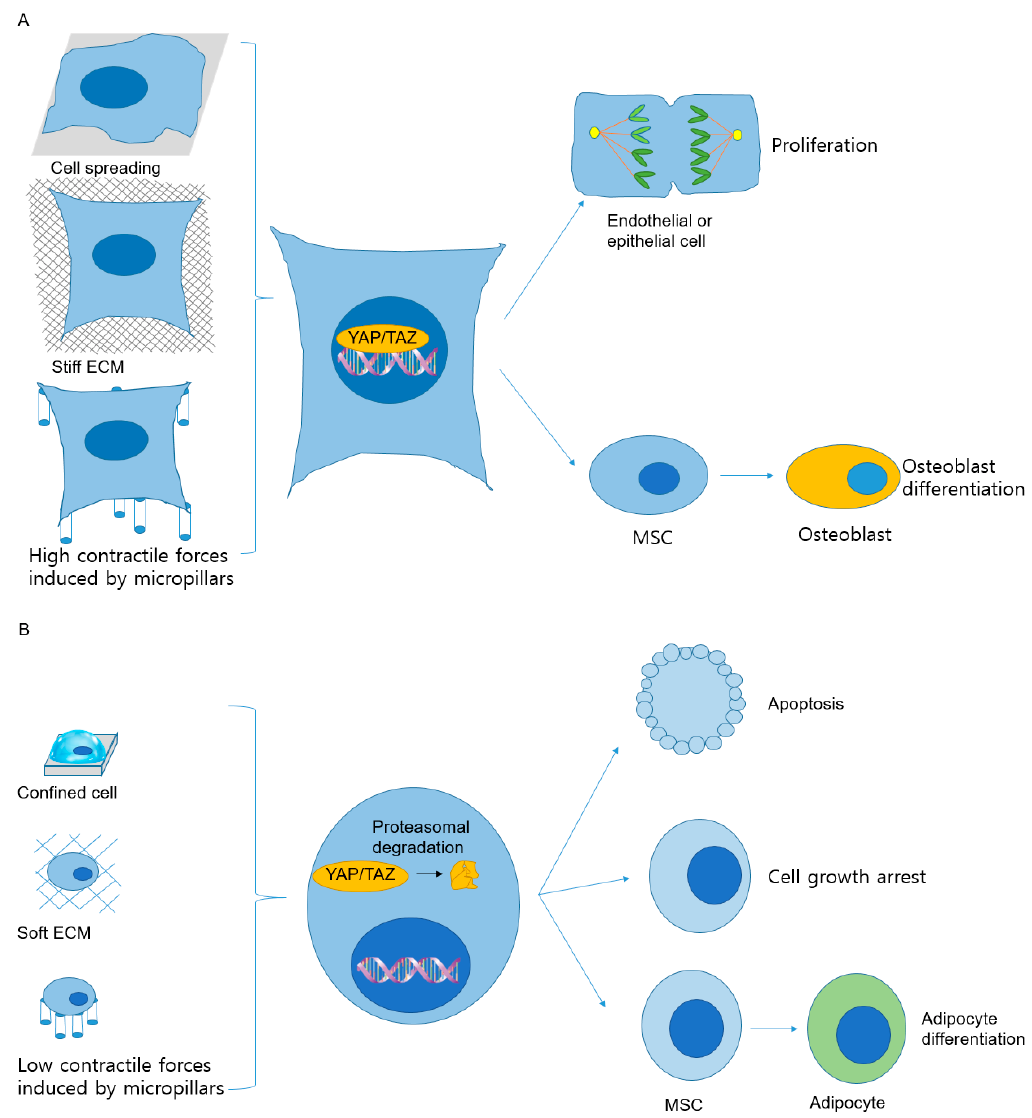
Figure 6. Mechanical stimuli induce YAP / TAZ translocation into the nucleus and determine cell fates [113,147] . ( A ) The translocation of the transcriptional regulators, YAP and TAZ, into the nucleus occurs under mechanical conditions that induce strong intracellular resistive forces and activate YAP and TAZ. In cells spread on an extensive adhesive area, cultured on solid extracellular matrices (ECMs), or stretched between micropillars, YAP and TAZ translocate into the nucleus and become active. Under these conditions, these transcriptional regulators are required for endothelial or epithelial cell proliferation and differentiation of MSCs to osteoblasts. ( B ) The inactivation and relocalization of YAP and TAZ in cytoplasm followed by proteasomal degradation of YAP and TAZ occur when the cells are confined on small adhesive areas or cultured on soft ECMs or on top of micropillars. The degradation results in weak contractile forces. Degradation of YAP and TAZ causes cell apoptosis, growth arrest, or differentiation of MSCs into adipocytes. Furthermore, the degradation and nuclear localization of YAP and TAZ are affected by ECM properties such as stiffness, area, and contractile force.